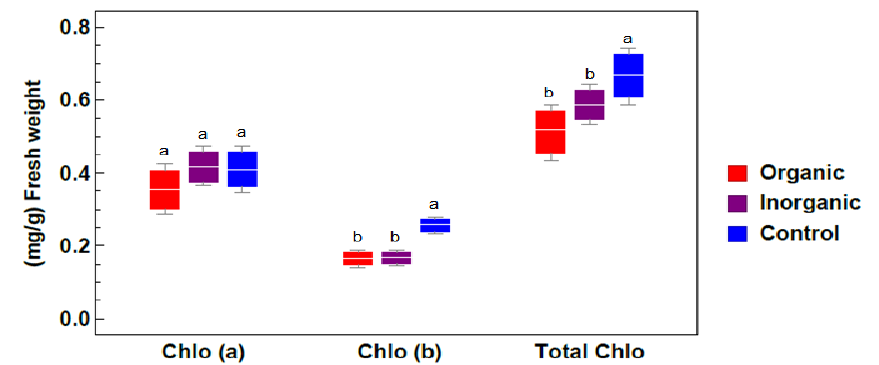
Figure 2. Impacts of di ff erent treatments on photosynthetic pigments in Azolla sp . plants. The photosynthetic pigments measured were chlorophyll a (Chlo a), chlorophyll b (Chlo b), and total chlorophyll (Total Chlo) (value (mg / g) ± the standard errors from three independent experiments under di ff erent treatments: organic, inorganic, and control). Di ff erent lowercase letters indicate significant di ff erences between di ff erent treatments at p ≤ 0.05 .